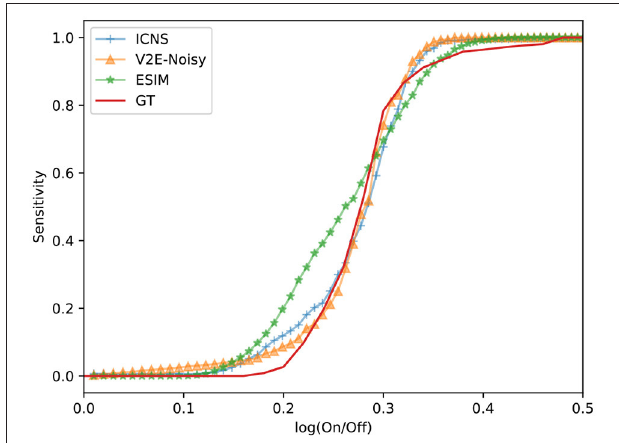
FIGURE 5 | Sensitivity of the different models as a function of the relative contrast On . The sensitivity measured on a real DVS pixel is also provided Off (GT). Both real and simulated pixels are stimulated with a square wave (10 Hz frequency), whose amplitude increases monotonically from 0 to 0.5 log. units.